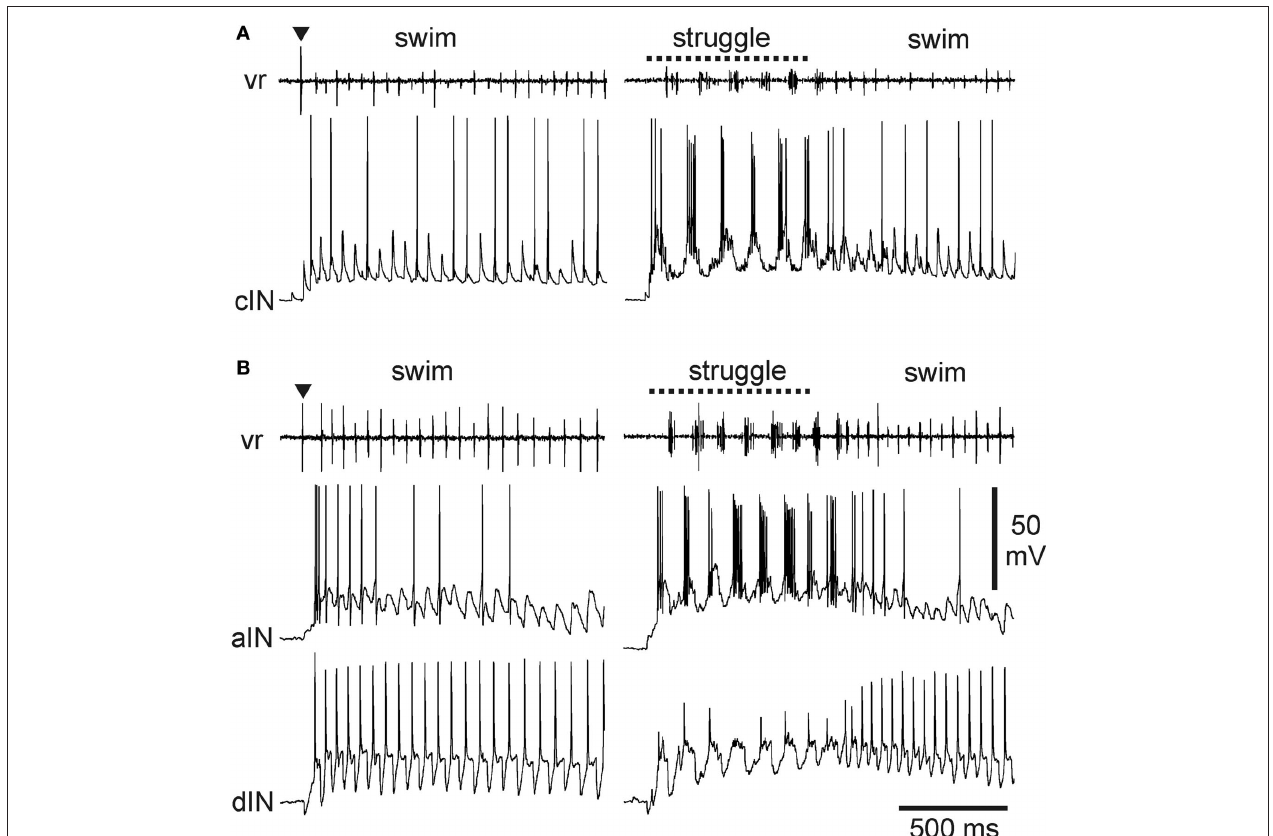
Figure 3 | Activity of multifunctional inhibitory neurons during tadpole swimming and struggling. (A) A cIN fires during swimming, evoked by a brief skin stimulus (  ), as well as struggling, evoked by 40-Hz skin stimulation (dashed line). Motor activity is recorded from a ventral root (vr) on the opposite side. The cIN fires a single impulse on many swimming cycles, driven by fast EPSPs that are seen on cycles where spikes fail. The cIN fires rhythmic bursts of